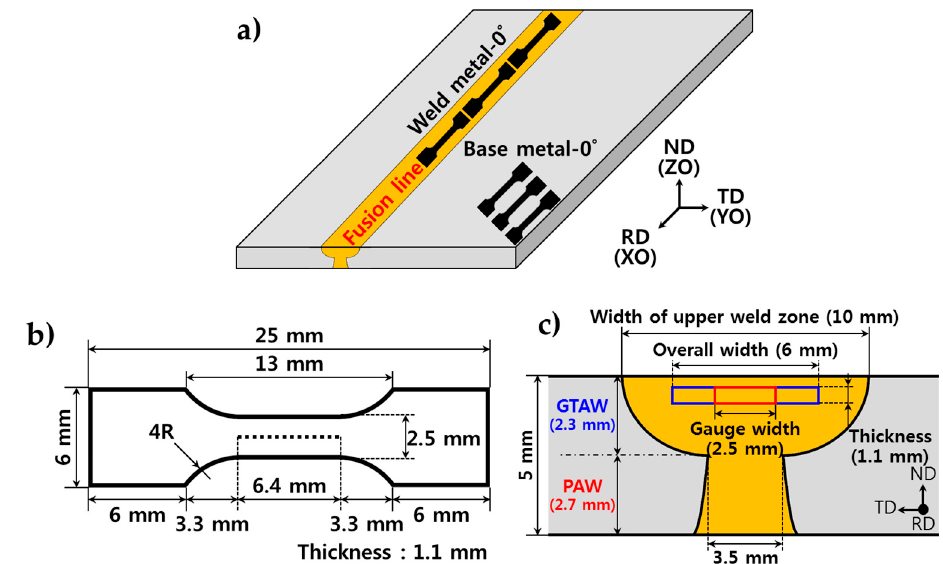
Figure 1. Schematic diagrams showing ( a ) location and direction of tensile specimens, ( b ) dimension of the present subsized tensile specimen, ( c ) sampling location of tensile specimen.